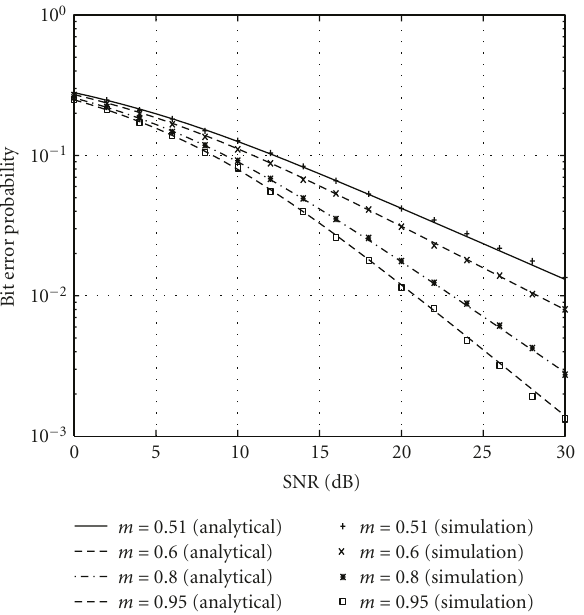
Figure 2: BEP for 64-QAM subject to Nakagami- m fading for di ff erent values of m , 0 . 5 < m < 1.